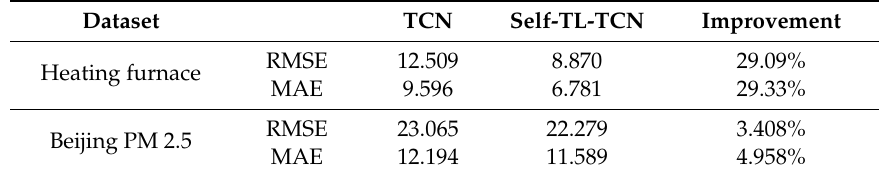
Table 6. Performance of TCN before and after structure and parameter.